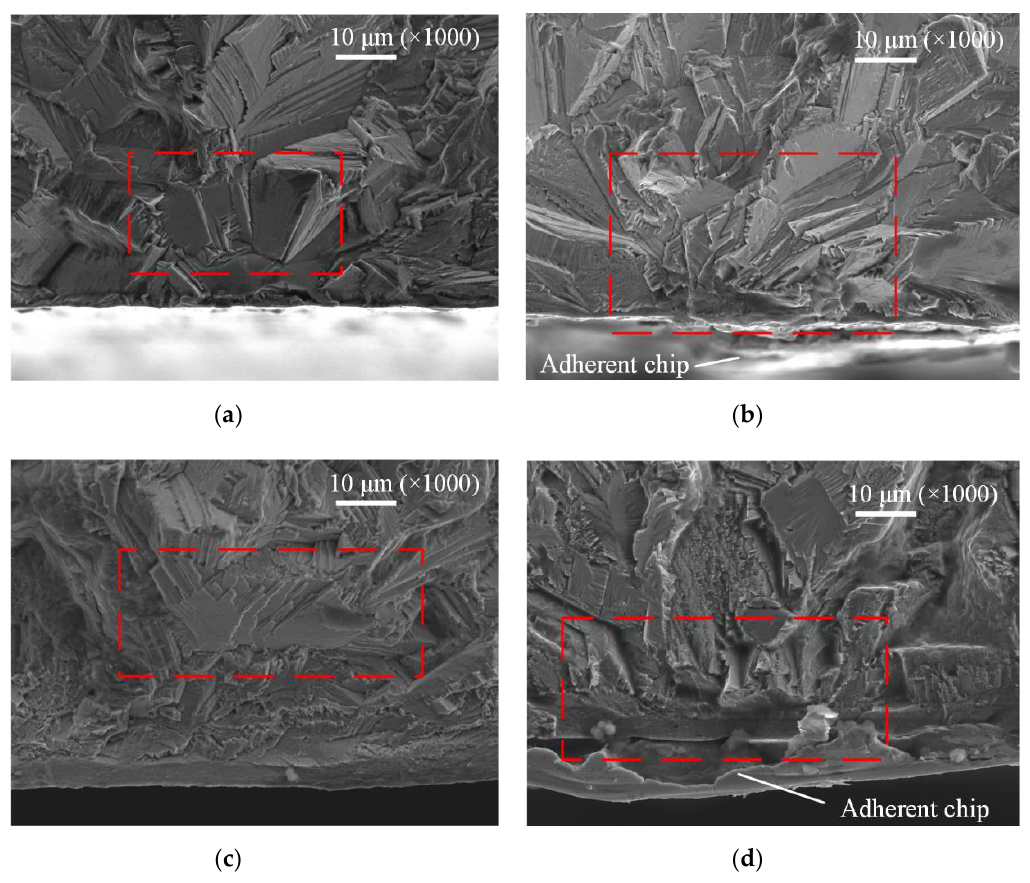
Figure 11. Fatigue fracture after milled workpieces with di ff erent cooling conditions: ( a ) VB = 0.05 mm (wet milling), ( b ) VB = 0.05 mm (dry milling), ( c ) VB = 0.20 mm (wet milling), ( d ) VB = 0.20 mm (dry